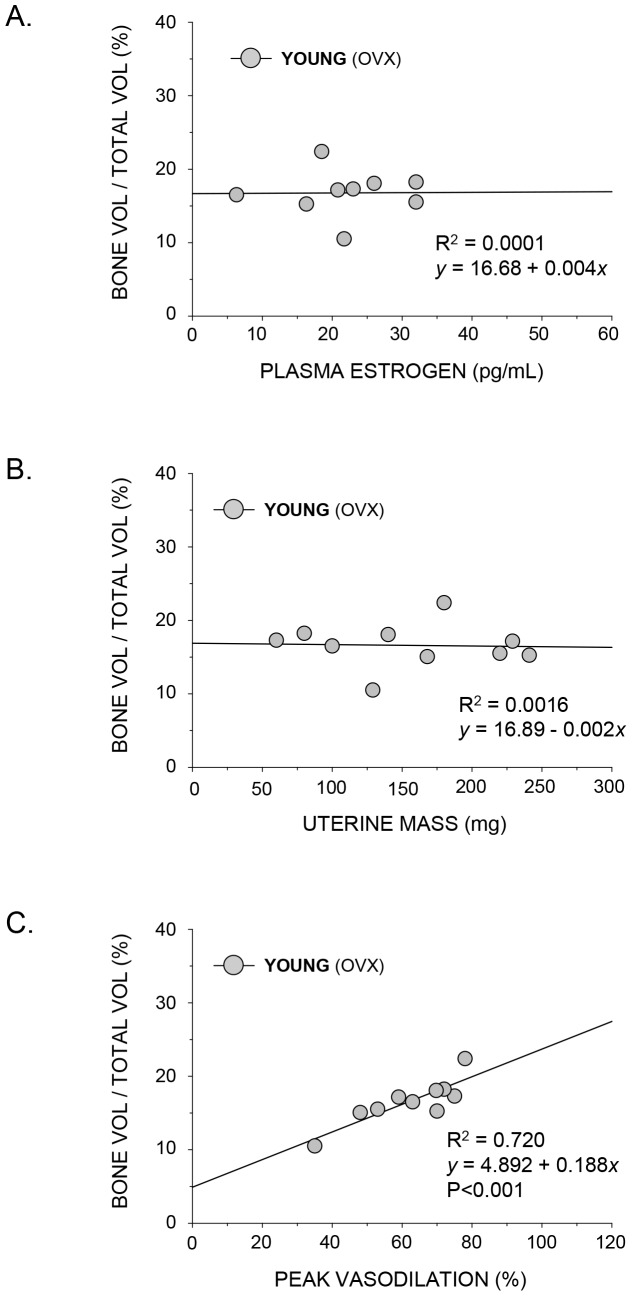
Scattergrams showing the relation between plasma estrogen, uterine mass and endothelium-dependent vasodilation on trabecular bone volume (BV/TV) in the distal femur of young ovariectomized rats.A) plasma estrogen concentration from animals with estrogen levels within the detectable range; B) uterine mass, a biomarker for reproductive hormone concentration ovariectomized; and C) peak endothelium-dependent vasodilation of the femoral PNA. BV/TV was not related to either plasma estrogen (A) or uterine mass (B) in this group, whereas a significant (P<0.001) linear relation exists between BV/TV and percent PNA vasodilation (C).